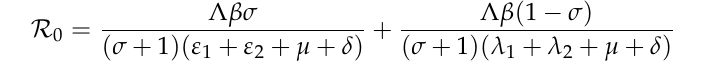
Table 2. Formulas and values of the sensitivity indices of